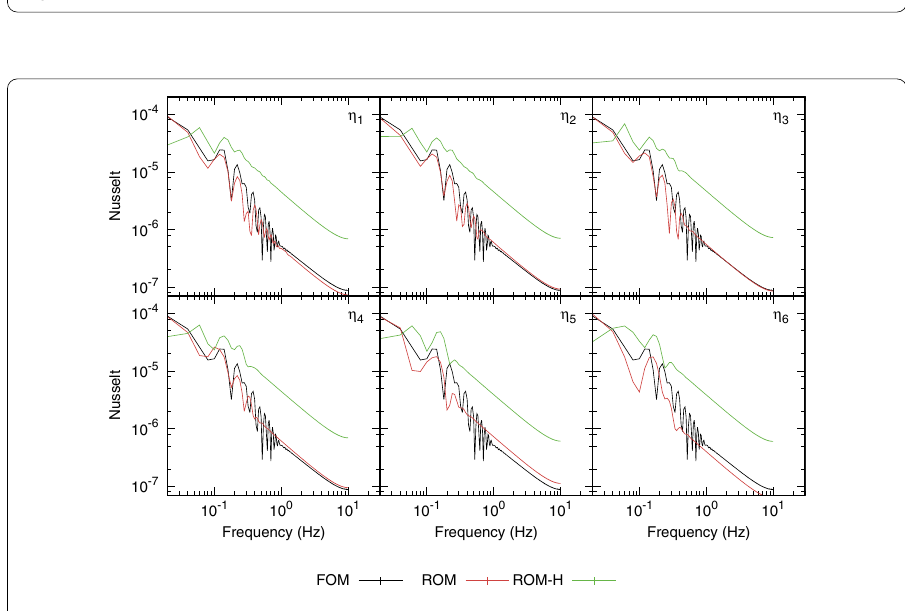
Fig. 14 Fourier transform of the Nusselt number for the cold